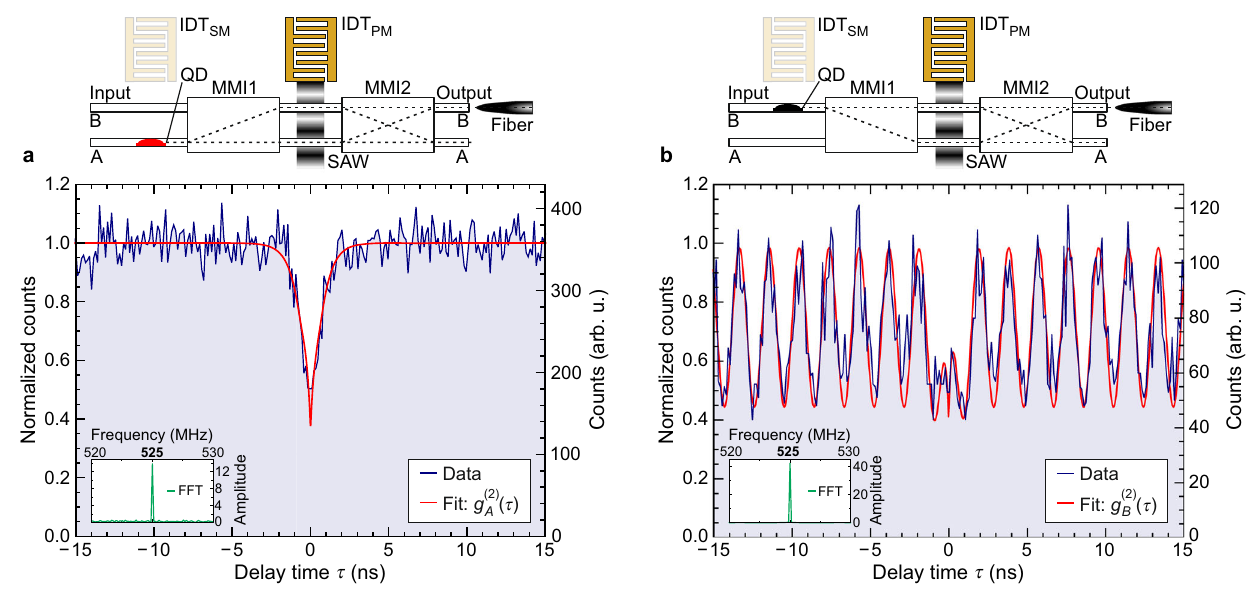
Fig. 3 | Photon antibunching of on-chip routed quantum dot emission. Upper panels show a schematic representation of the experimental con fi guration: the optical transition of a single QD in Input WG-A ( a , red) or Input WG-B ( b , black) is not modulated (IDT SM is inactive) while the response of the MZI is modulated (IDT PM isactive) asthe photonspasses. Emission iscollected from Output WG-B in